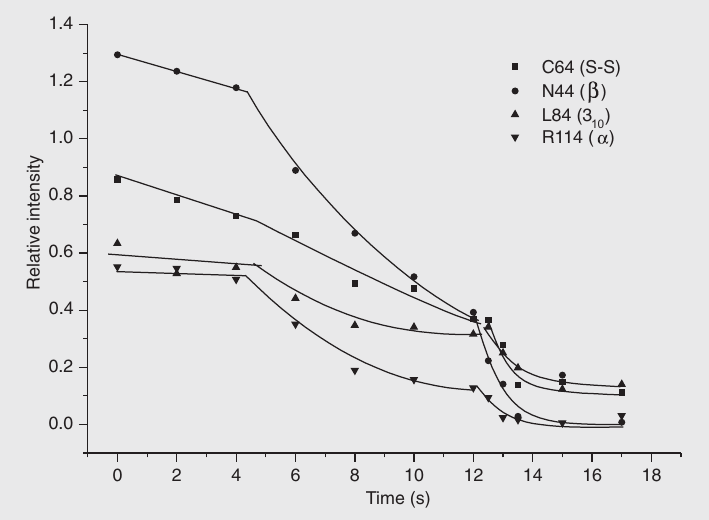
Figure 1. Cross-peak intensities of the amino acid residues C64, N44, L84, and R114 of hen egg white lysozyme as a function of time under heat-denaturing conditions (10% lysozyme, 20 mM citrate buffer, pD 3.4, at 80 º C). Residue C64 contains a disulfide bridge (S-S). N44 is part of a ß-sheet (ß), L84 and R114 are in helical regions of the protein (a 3 10 and an α -helix, respectively). The exchange-behavior can be separated into three phases: an equilibration phase where the system reaches thermal equilib- rium, a slow, transient exchange phase and a final, fast exchange phase.